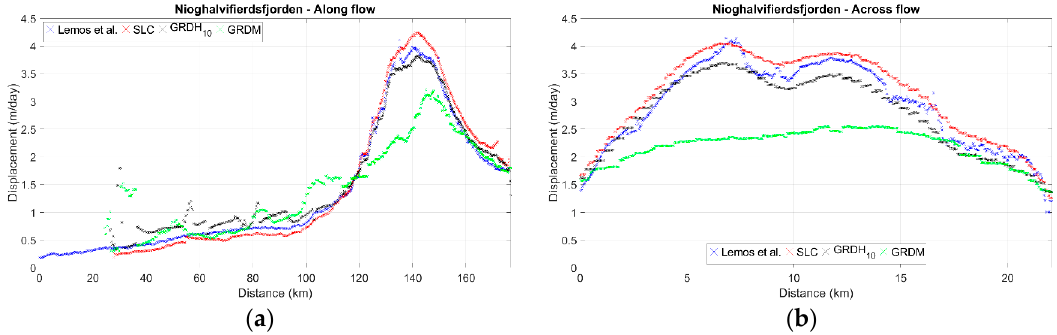
Figure 7. NI, average annual flow speed for reference data (blue curve) and all the analyzed products (IW SLC red curve, IW GRDH black curve, EW GRDM green curve). ( a ) Along flow speed. ( b ) Across flow speed.